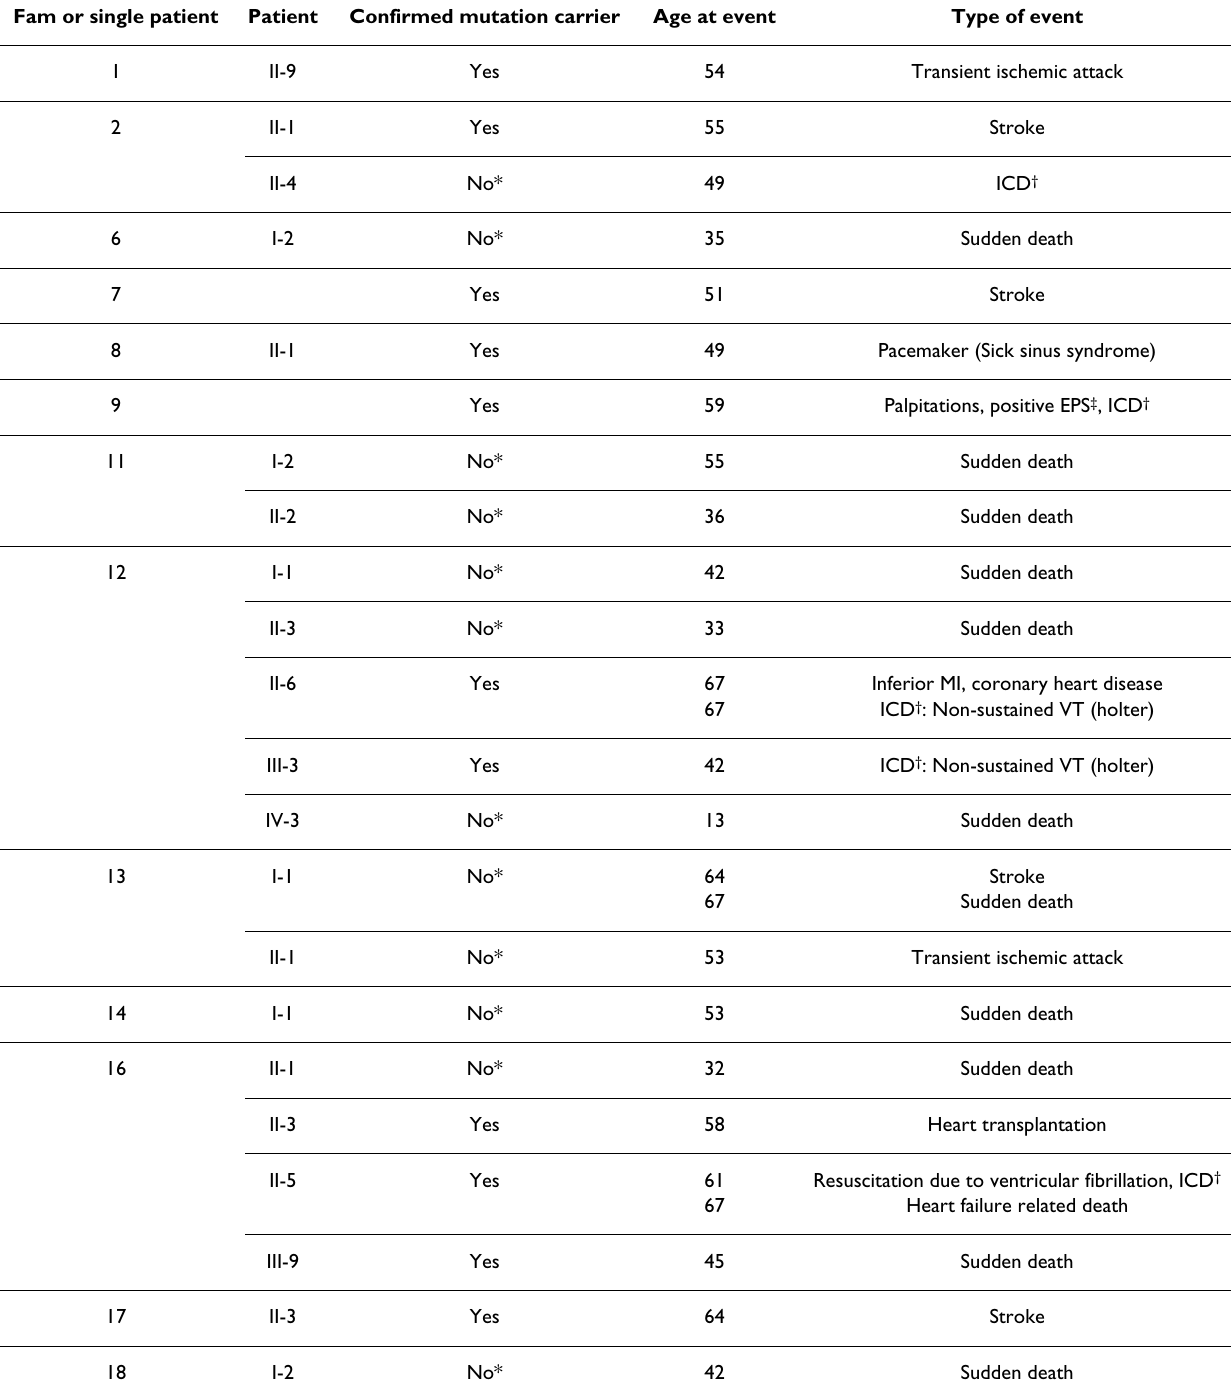
Table 3: Adverse events in families of MYBPC3 mutation carriers Fam or single